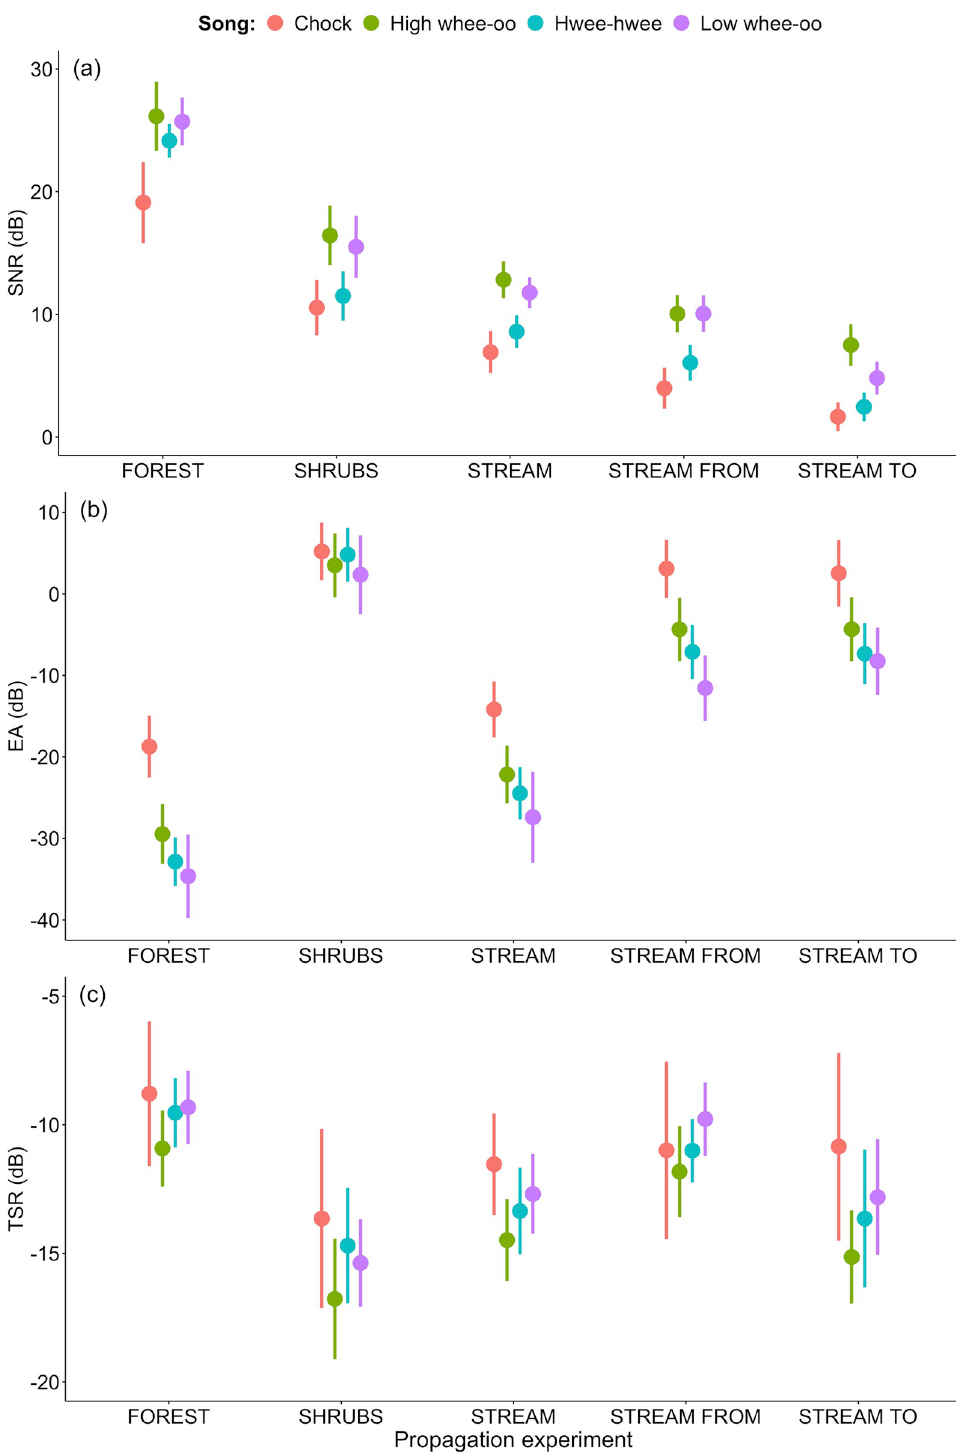
Fig 6. Signal-to-noise ratio (SNR ± SD dB), excess attenuation (EA ± SD dB) and tail-to-signal ratio (TSR ± SD dB) measured after 25m of propagation for male (High whee-oo, Low whee-oo, Hwee-hwee) and for female (Chock) songs—comparison of all propagation